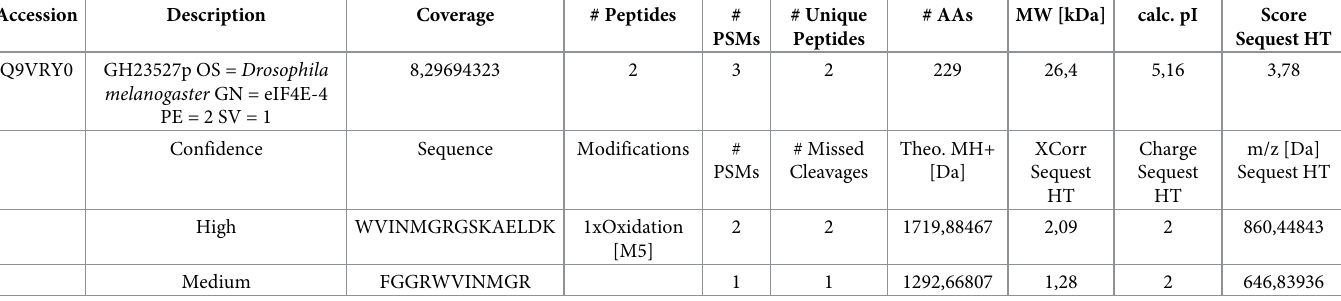
# Unique # AAs Score PSMs Peptides Sequest HT